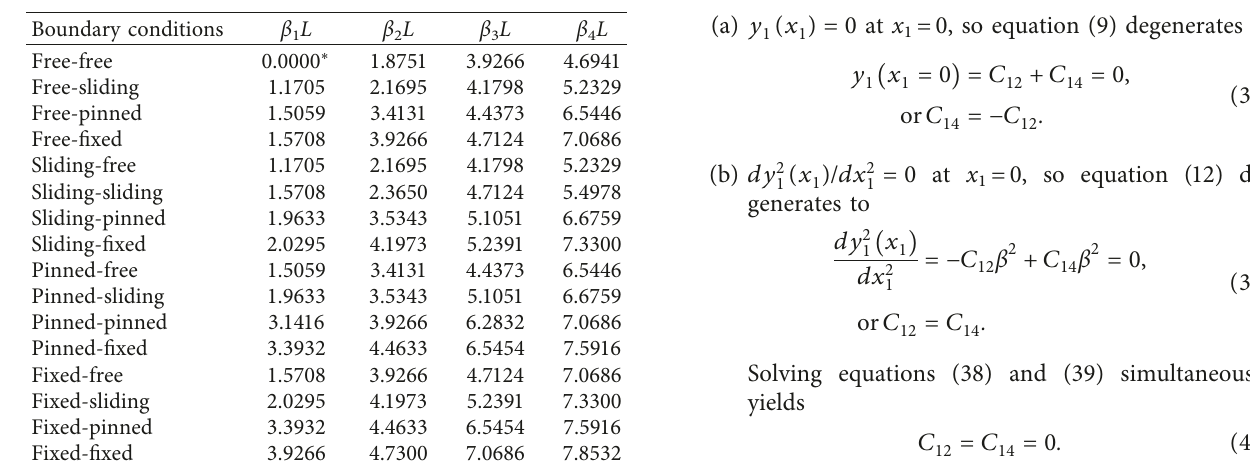
Table 3: Frequency parameters for two-span beams with various end support